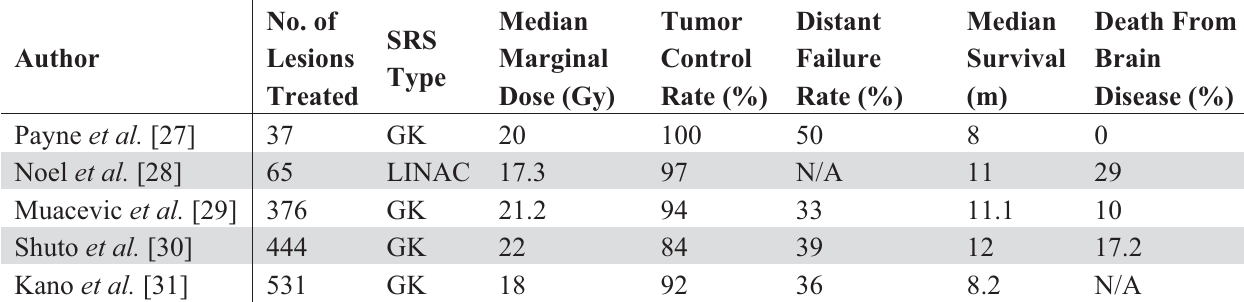
Table 1. Selected SRS series in RCC brain